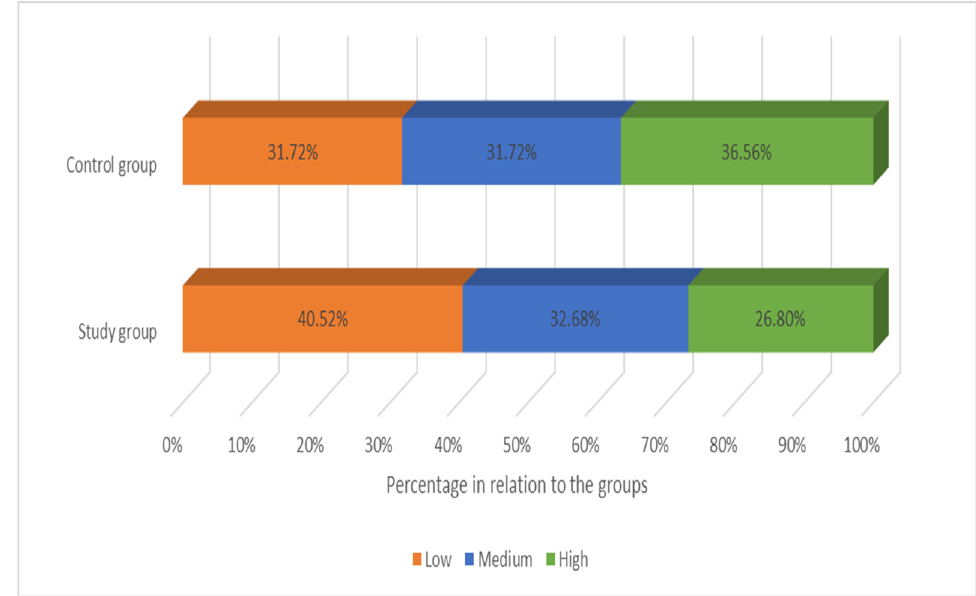
Figure 7. Severity of resilience depending on the group.